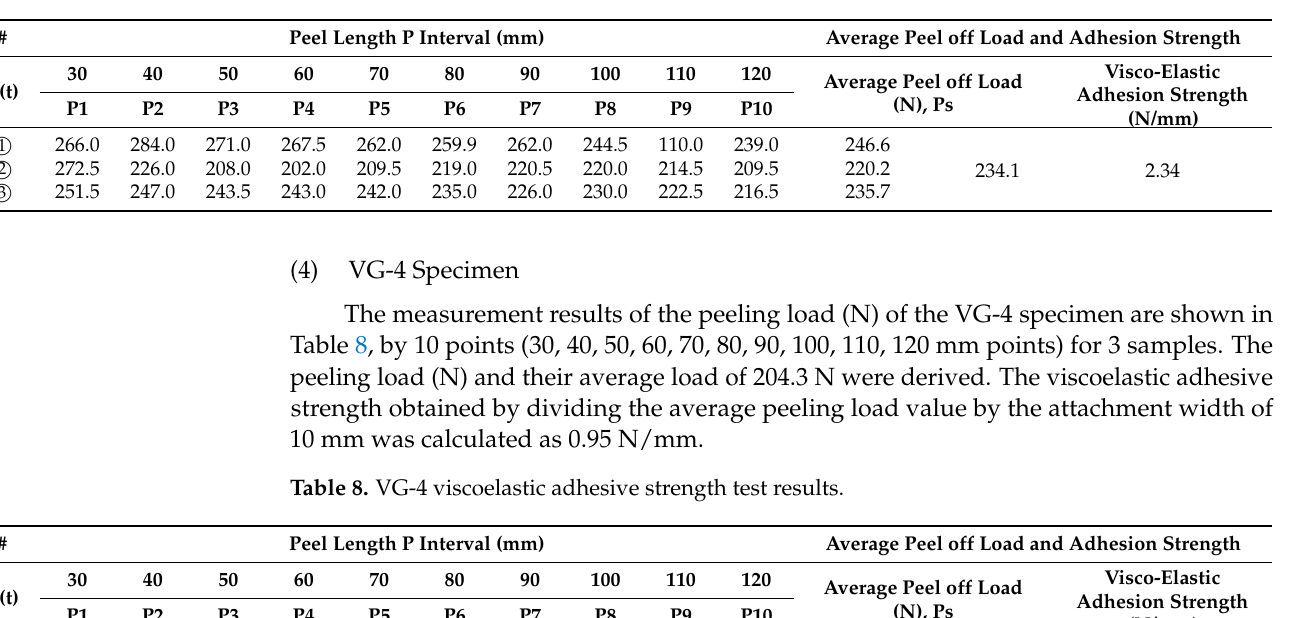
Table 7. VG-3 viscoelastic adhesive strength test results.